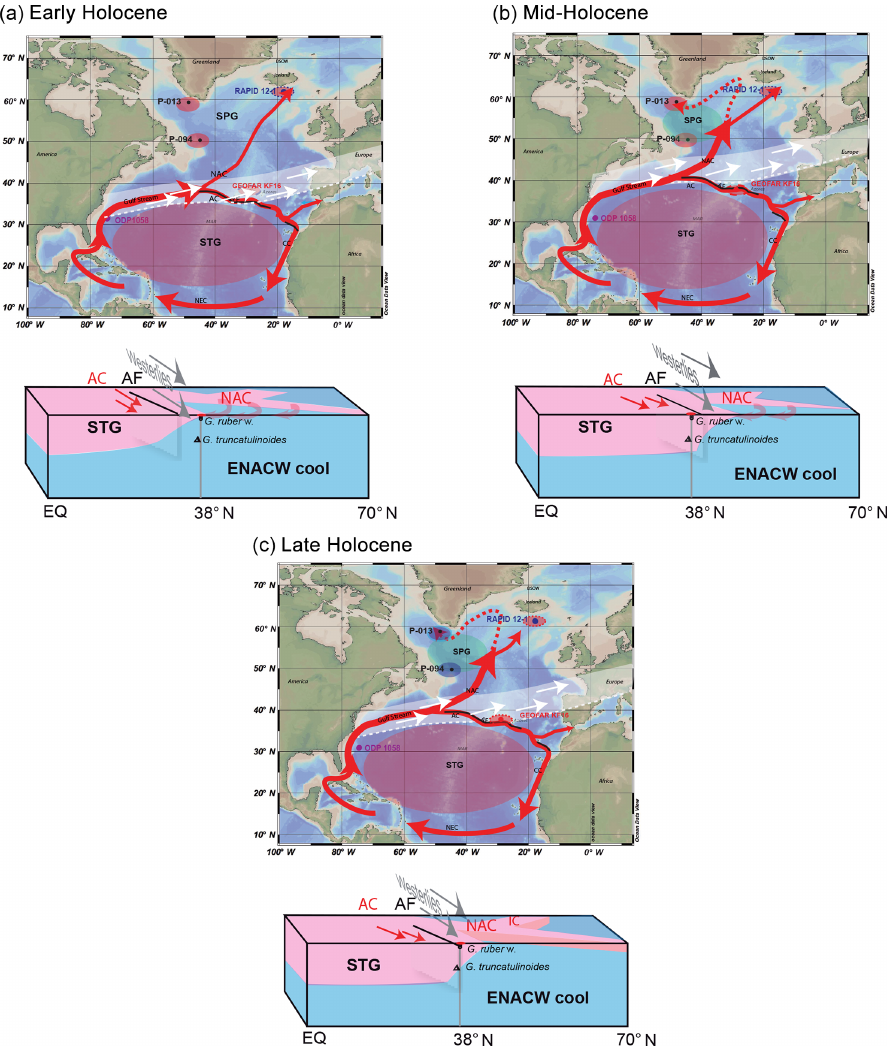
Figure 5. Conceptual model showing the three different states of subsurface transport: (a) early Holocene meltwater phase, (b) mid-Holocene transitional phase, and (c) late Holocene modern phase. Abbreviations are AC, Azores Current; AF, Azores Front; ENACW, Eastern North Atlantic Central Water; NAC, North Atlantic Current; STG, subtropical gyre; and SPG, subpolar